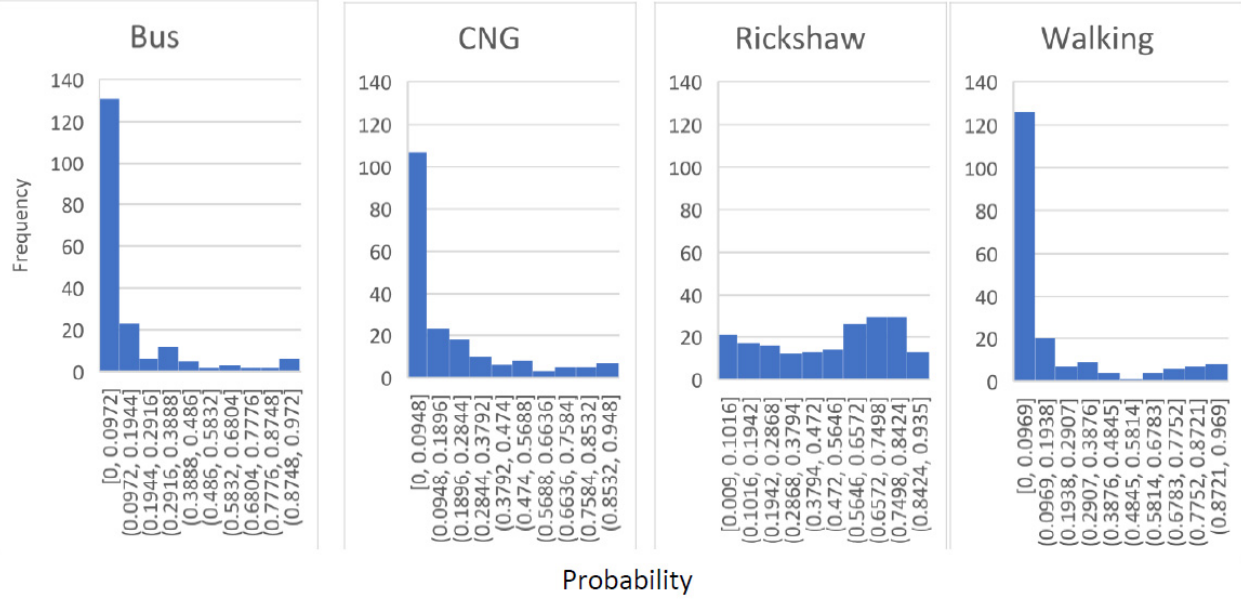
Figure 8. Probability of selecting bus, CNG, rickshaw, and walking by LDA for test data.